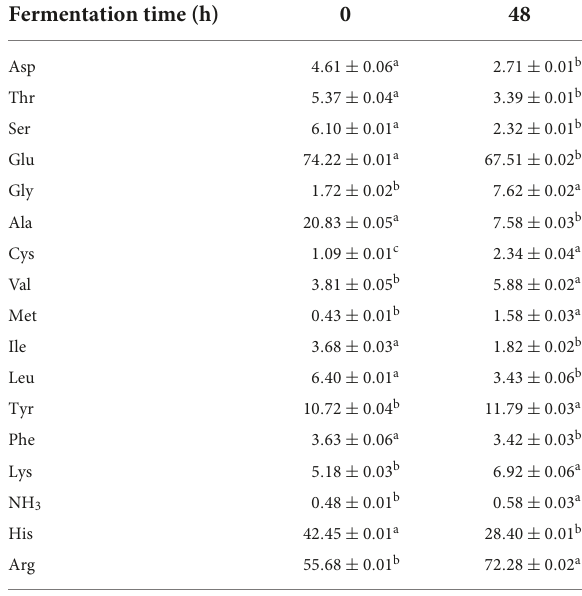
TABLE 4 Changes in the content of different free amino acids in fermented and unfermented ( µ g/mL). Fermentation time